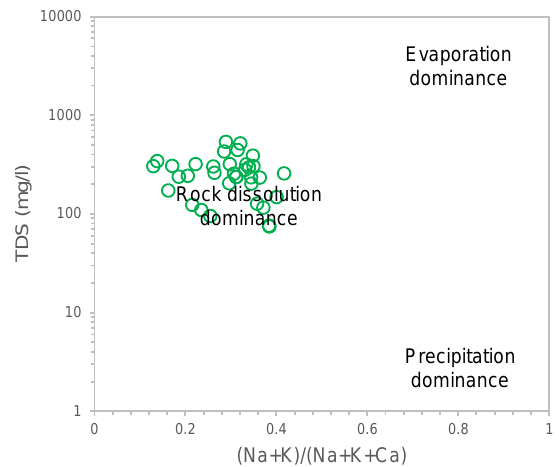
Figure 6. Gibbs diagram of study area groundwater samples showing dominance of rock dissolution. Calculations are shown on